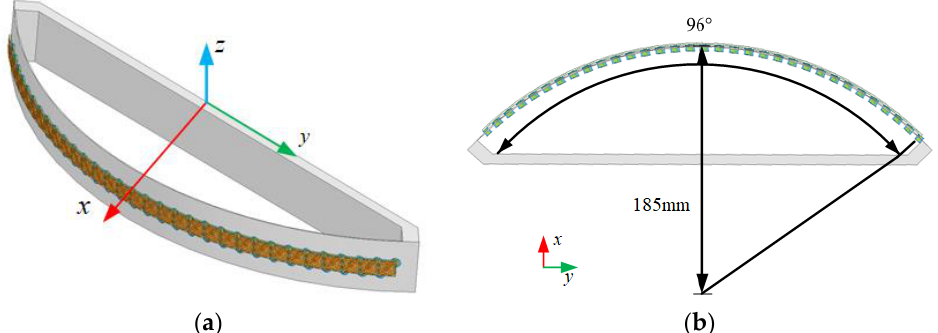
Figure 6. Array antenna model of ( a ) overall view ( b ) top view. The antenna elements conformal to the cylindrical surface are excited with equal amplitude and proper phase to direct the array beam. The feeding phase of the i th element is